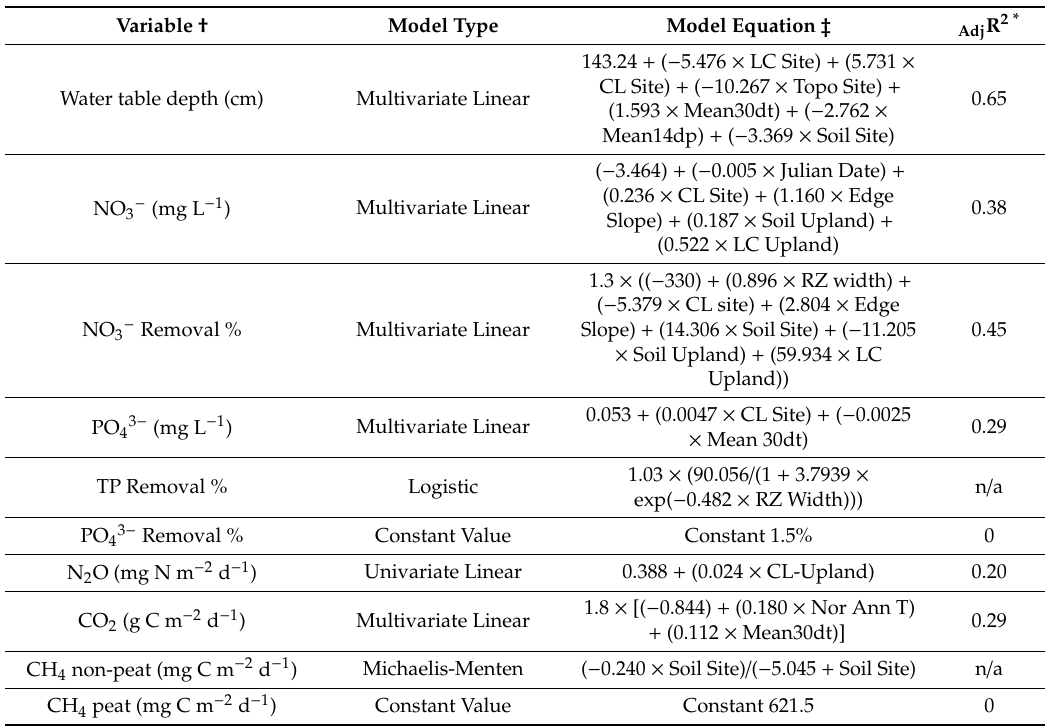
Table 5. Description of individual models for each riparian function represented in the RZ-TRADEOFF water and air quality